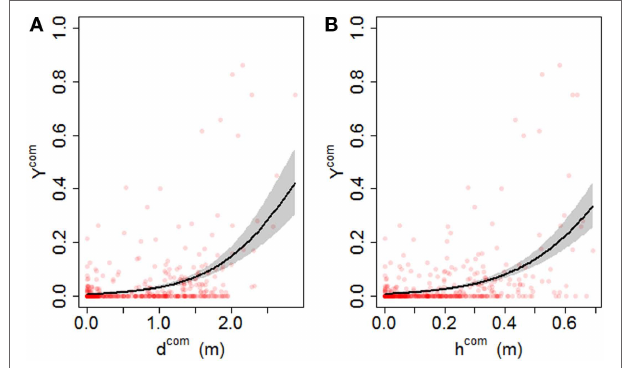
FIGURE 10 | Community response (ratio of buildings with at least minor damage) as a function of (A) average house inundation and (B) average significant wave height. Data points represent raw data for 464 discretized communities in study area. Solid black curve and shaded black region represent the estimated expected community response and associated 95% confidence interval, respectively.